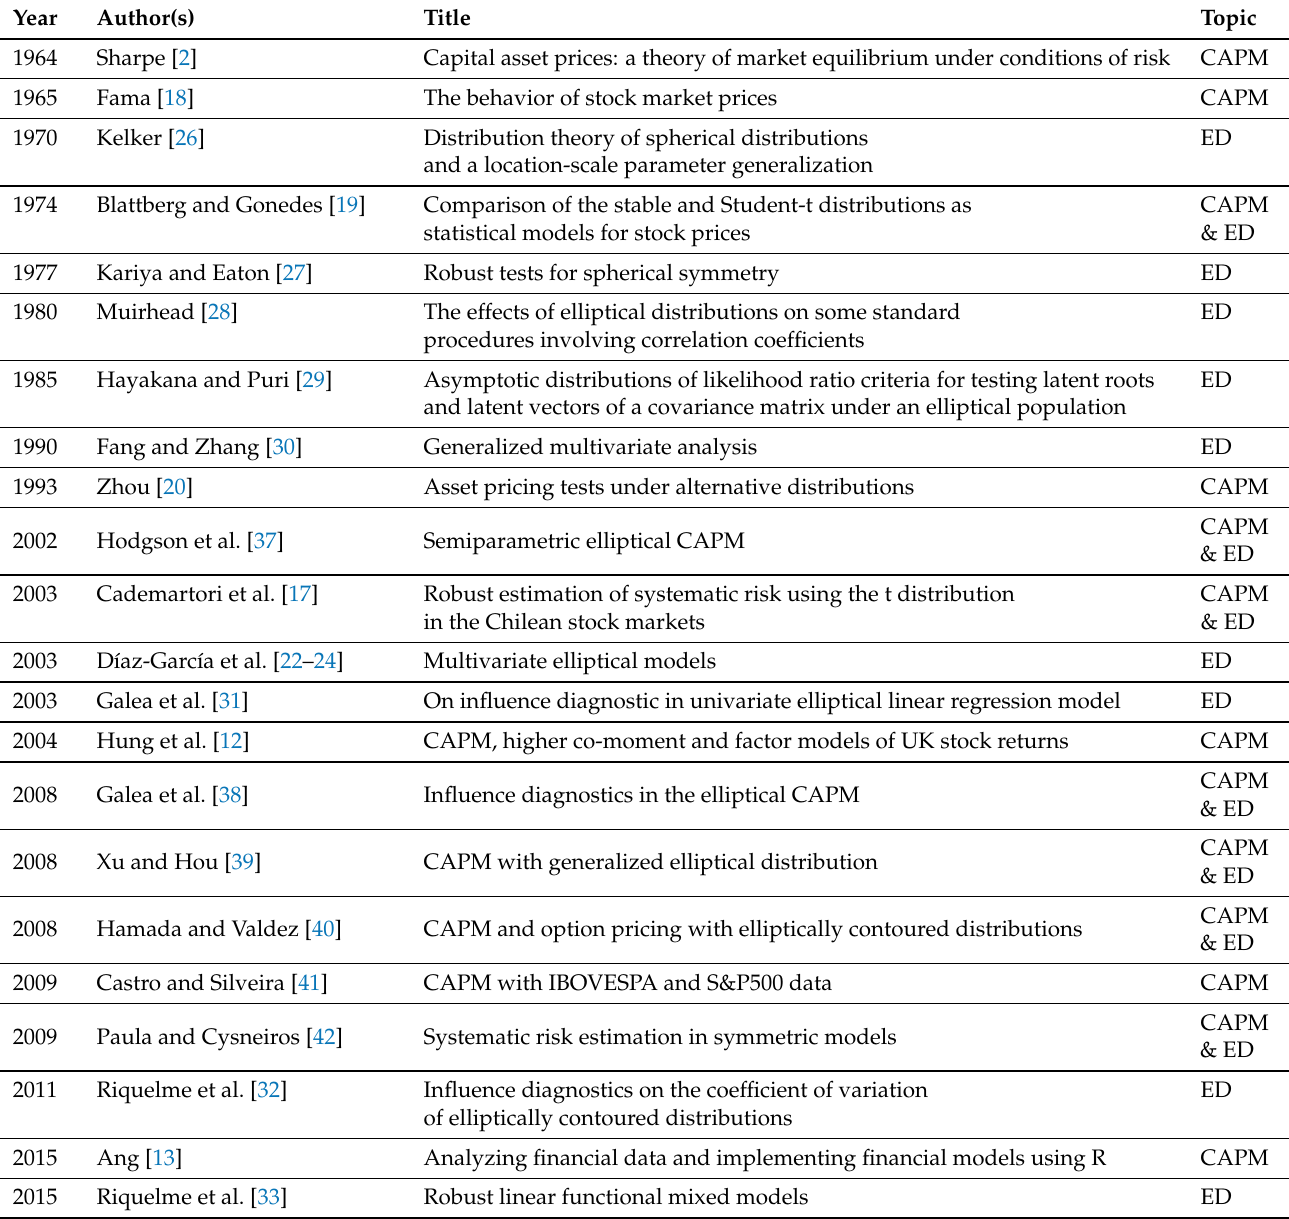
Table 1. Research on CAPM and symmetric/elliptical distributions